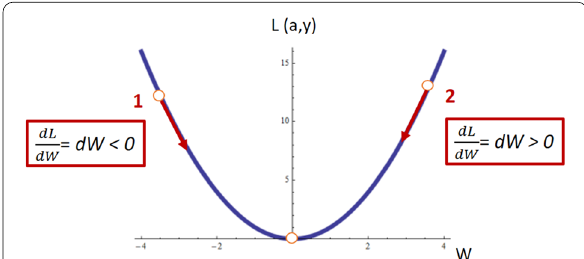
Fig. 8 Minimization of a parable. The random W value at point 1 presents a negative slope while at point 2 presents a positive slope